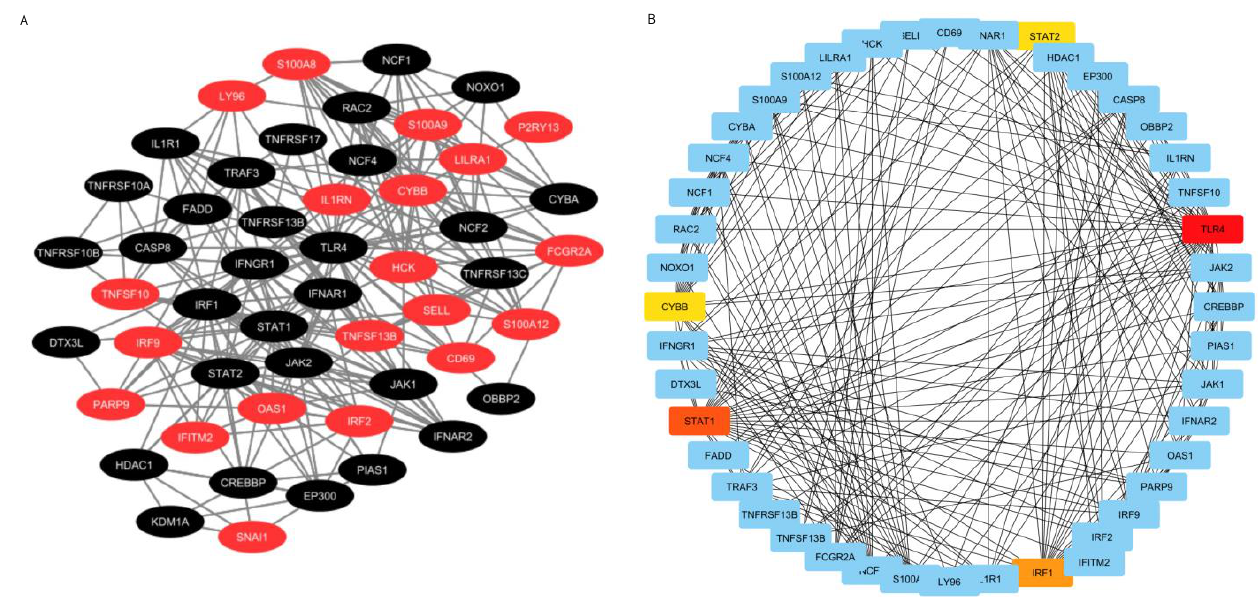
Figure 4. PPI network construction and hub genes extraction. ( A ) Protein – protein interactions (PPI) network of common DEGs between COVID-19 patients with and without cancer. The common genes are highlighted with red nodes. The network contains 51 nodes and 542 edges. ( B ) The hub genes were extracted from the PPI network of common DEGs. According to the degree value, the highlighted TOP5 hub genes are TLR4, STAT1, IRF1, CYBB and STAT2. The network is made up of 47 nodes and 263 edges.